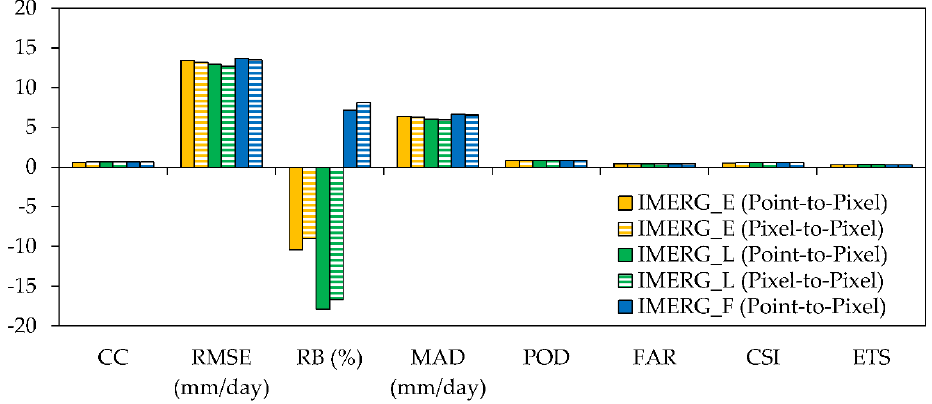
Figure 10. Comparison of point-to-pixel and pixel-to-pixel approaches in measuring statistical metrics from 12 March 2014 to 31 December 2016 over Kelantan River Basin.